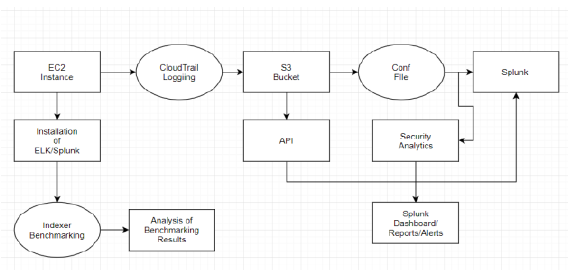
Figure 4. Splunk Sample Authorize VS Revoke activity for Security Groups